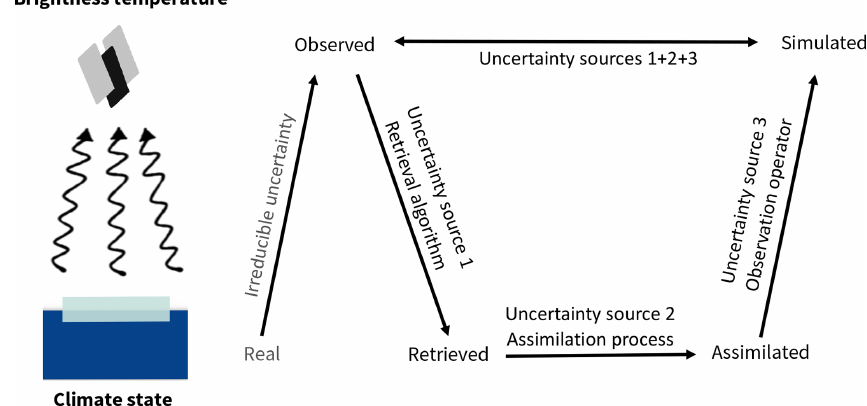
Figure 3. Uncertainty sources possibly introducing differences between simulated and observed brightness